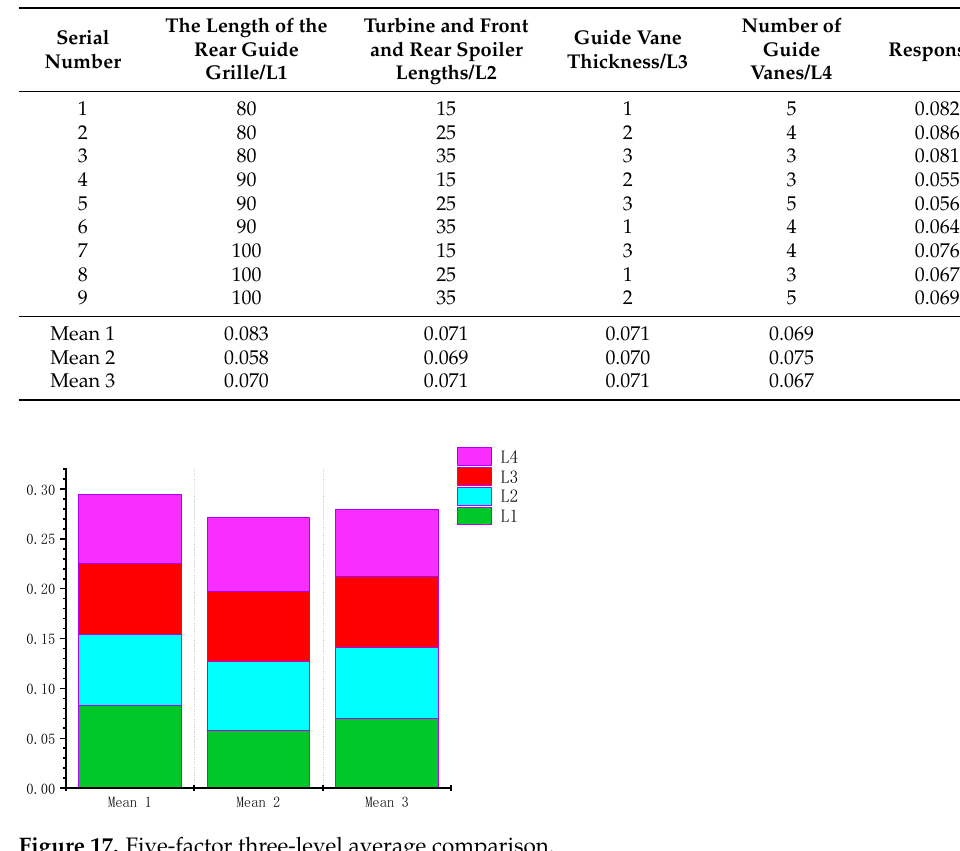
Table 8. Orthogonal experiment results and mean.